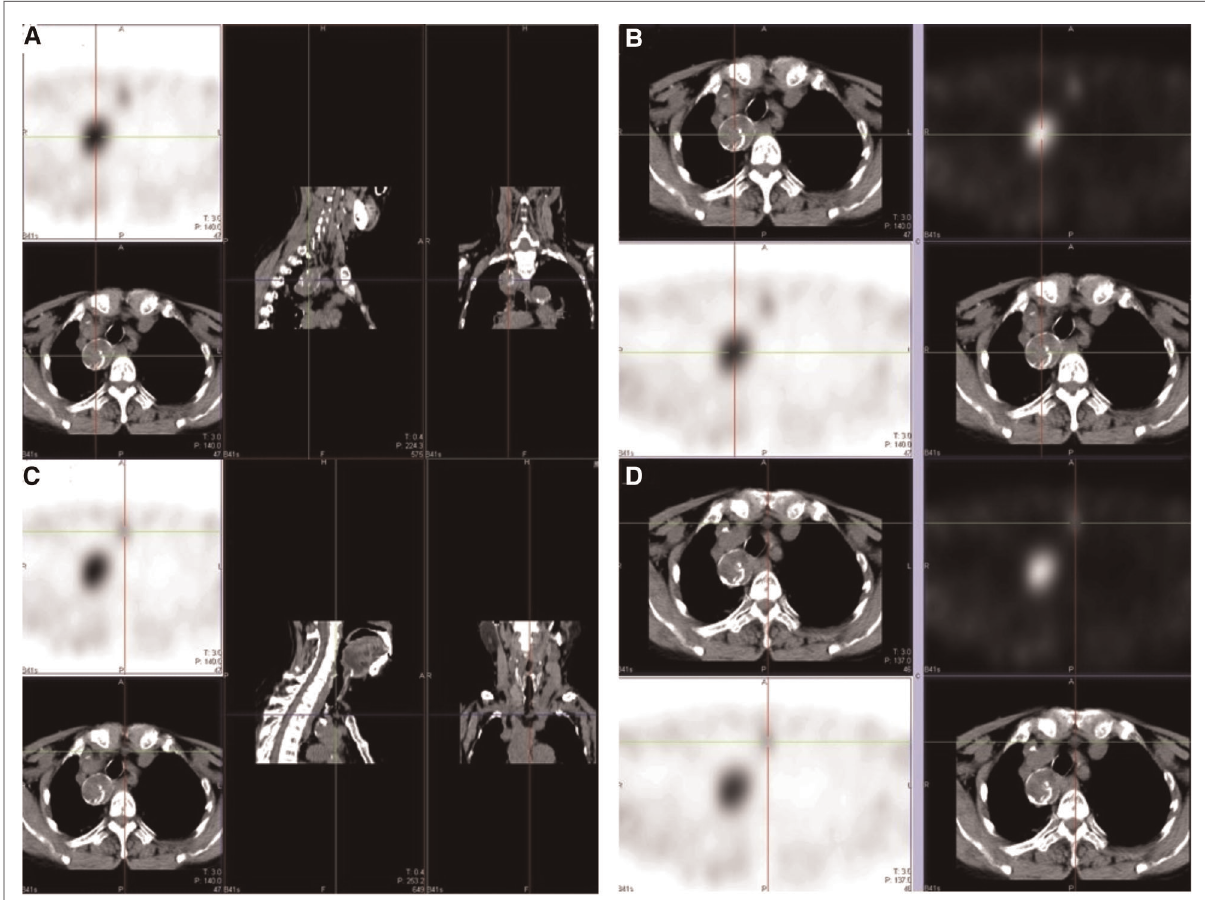
FIGURE 2 MIBI examination. ( A, B ) Large soft tissue density nodule accompanied by eggshell calci fi cation in the superior mediastinum, located behind the innominate artery and beside the trachea; ( C, D ) soft tissue density nodule in the suprasternal